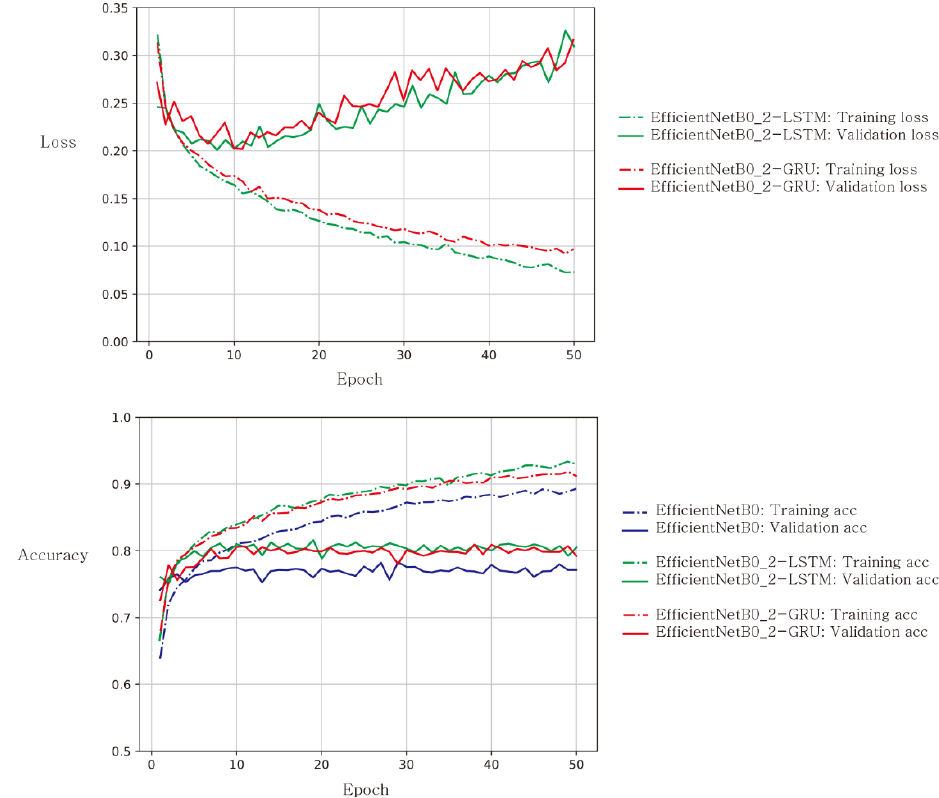
Figure 2. Learning curves for loss ( top ) and accuracy ( bottom ) when EfficientNetB0 was used as a baseline CNN architecture. Solid lines represent validation results, while dashed lines represent training results. Loss curves for EfficientNetB0 were not plotted because their loss value ranges were well above those for EfficientNetB0_2-LSTM and EfficientNetB0_2-GRU.